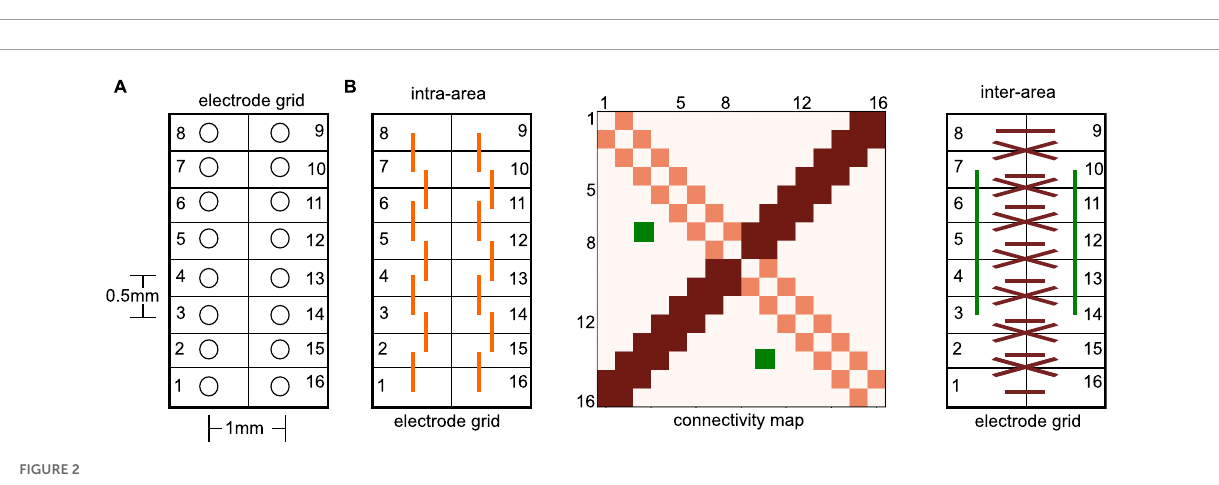
FIGURE1 Electrode placement and stimulation protocol. (A) The 2 × 8 electrode grid was implanted on the border of the parietal association cortex (PtA) and the secondary visual cortex (V2). The schematic is overlaid on a partial dorsal view of the rat brain. (B) The brainstem stimulation was applied in the pontine reticular nucleus (PnO). Schematic is overlaid on a sagittal view of the rat brain. (C) Temporal stimulation protocol with PnO stimulation marked as green vertical lines. Modified from Figure 1 in Pillay et al. (2014b) with permission.